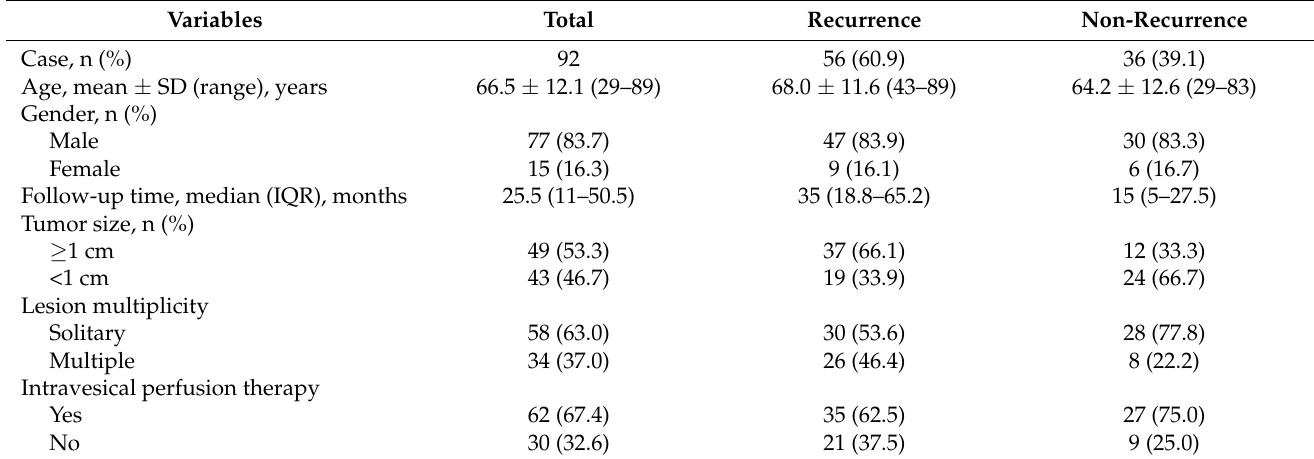
Table 2. Clinical characteristics of postoperative bladder cancer patients.